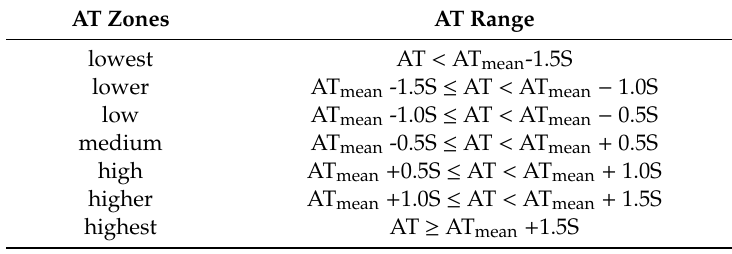
Table 1. The classification of air temperature (AT) zones for the whole study